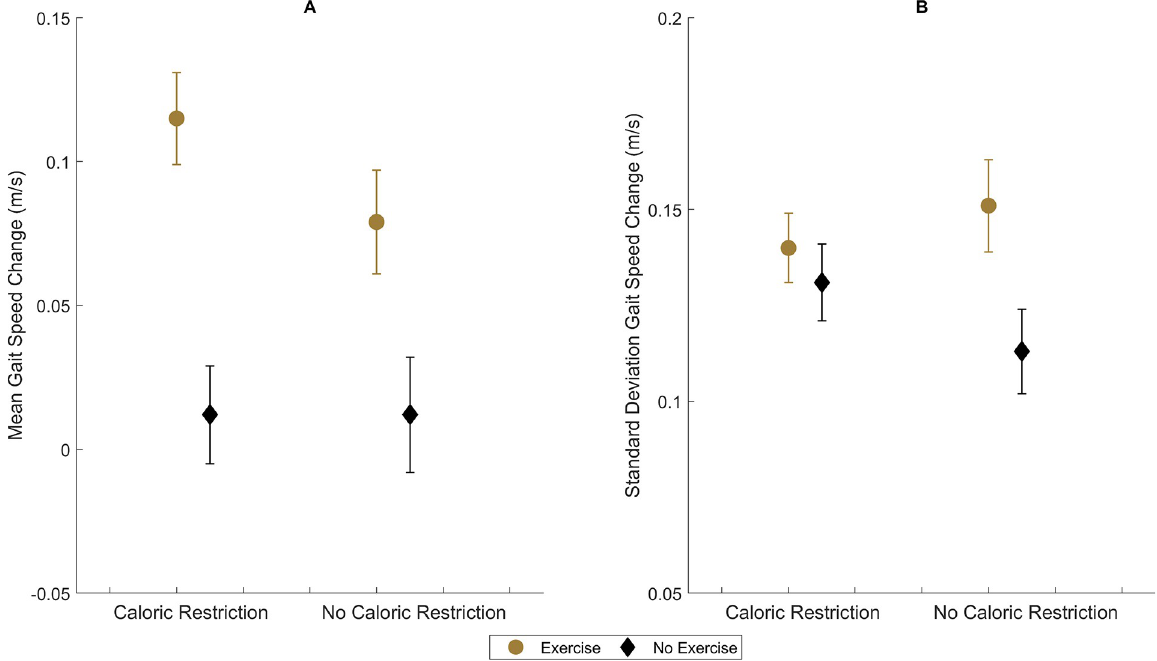
Fig 2. Effect of exercise subgroup membership on change in fast-paced gait speed mean (A) and variance (B) heterogeneity in response to caloric restriction. Presented as model-adjusted parameter means and 95% Bayesian Credible Intervals.